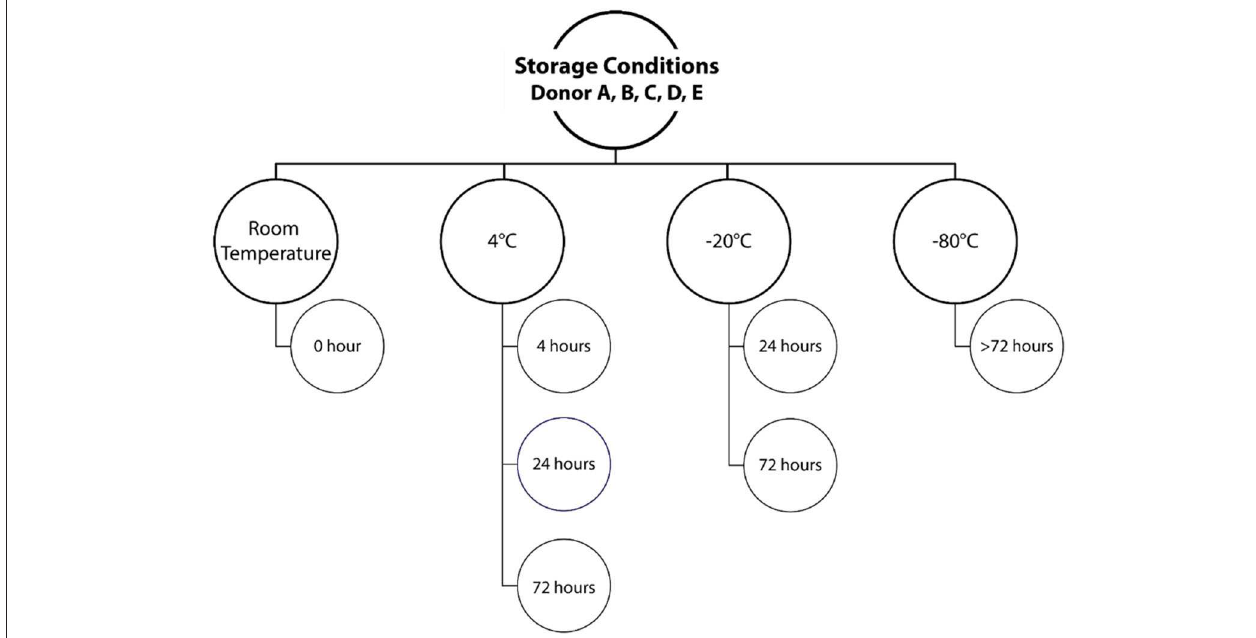
FIGURE 1 | Urine storage conditions. Voided urine samples from each of the five study participants were either processed directly (room temperature, 0h) or stored at different temperatures for different time periods. Duplicate samples were included for each storage condition.